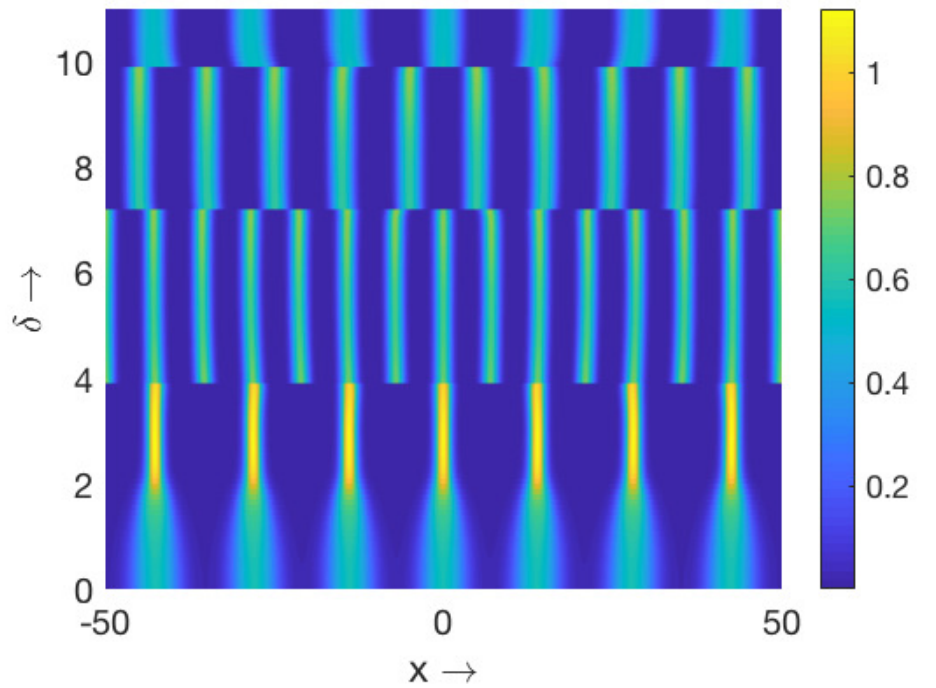
Figure 15. Color plot of density of the first prey species ( u 1 ) using the forward continuation technique. Here, (cid:101) = 5.0, d 3 = 9.0 and other parameter values are mentioned in